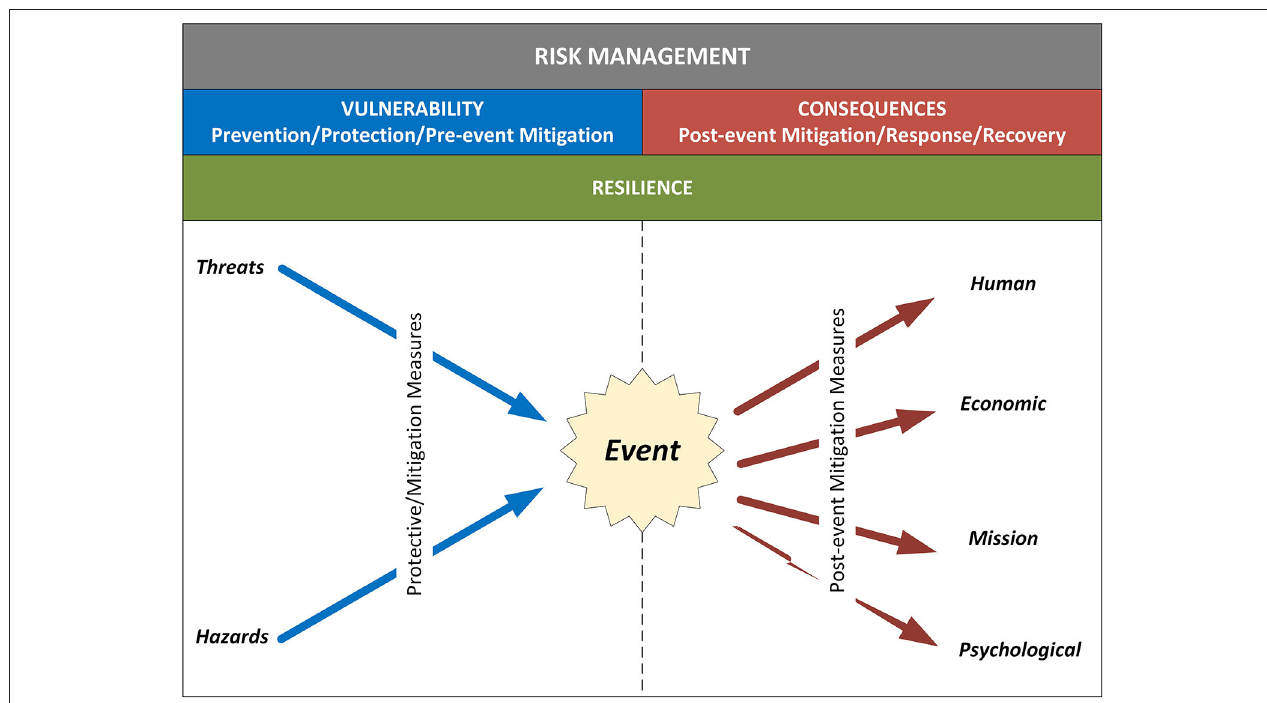
FIGURE 1 | Risk management. By understanding the likelihood of various threats and hazards, associated vulnerabilities, potential consequences, and resilience characteristics, stakeholders can make informed decisions on ways to manage risk (i.e., accept, transfer, avoid, or